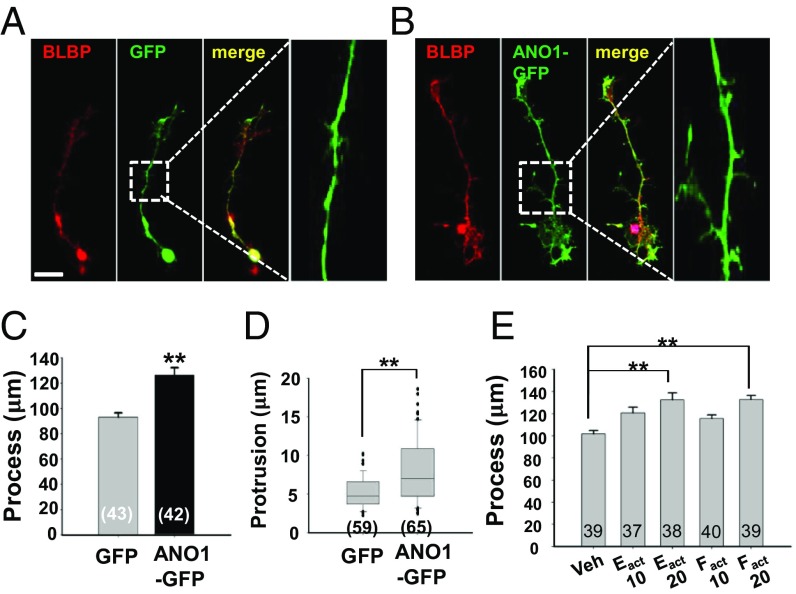
The process extension in RGCs after transfection or pharmacologic activation of Ano1. (A and B) Representative immunofluorescence images of RGCs transfected with Gfp (A) or Ano1-Gfp (B). (Right) Expanded images of the regions in white squares. (Scale bar: 20 μm.) (C and D) Summary of the lengths of processes (C) and protrusions (D) of RGCs transfected with Gfp or Ano1-Gfp. All experiments involving counting were validated from three to five independent cultures. (E) Summary of the process length of cultured RGCs pretreated with Eact (10 or 20 μM) and Fact (10 or 20 μM) for 3 d. RGCs were immunostained with BLBP to measure process length. **P < 0.01, one-way ANOVA and Tukey’s post hoc test.